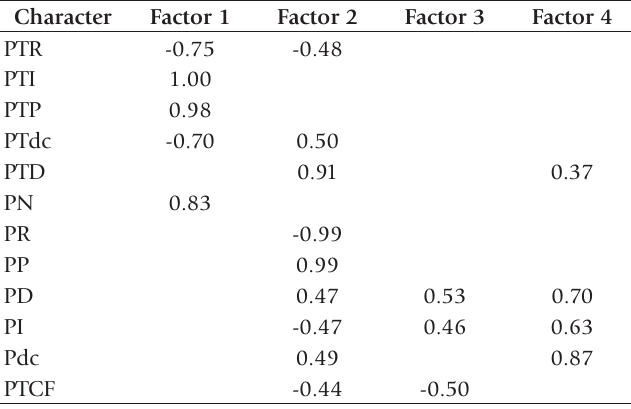
Fig. 4. Scree test results from the nFactors R package. The distinct inflection point of the eigenvalues plot at n = 4 components sug- gests extraction of that quantity of factors. Table 2. Loadings of song characters onto four factors as returned by maximum likelihood factor analysis.